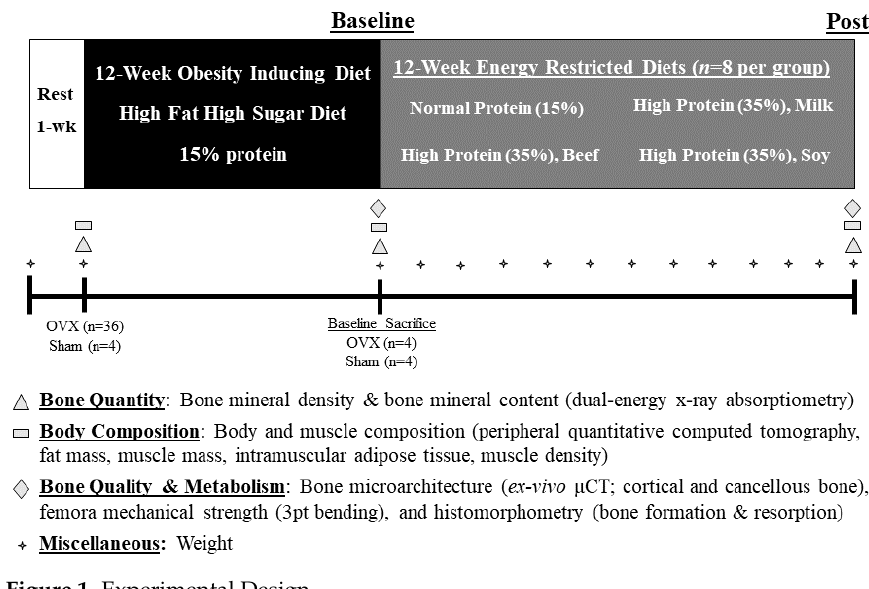
Figure 1. Experimental Design.